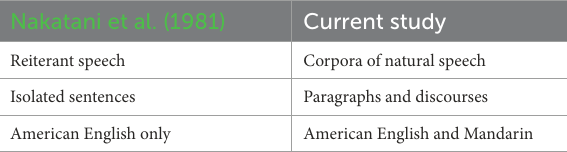
TABLE 2 Differences between Nakatani et al. (1981) and current